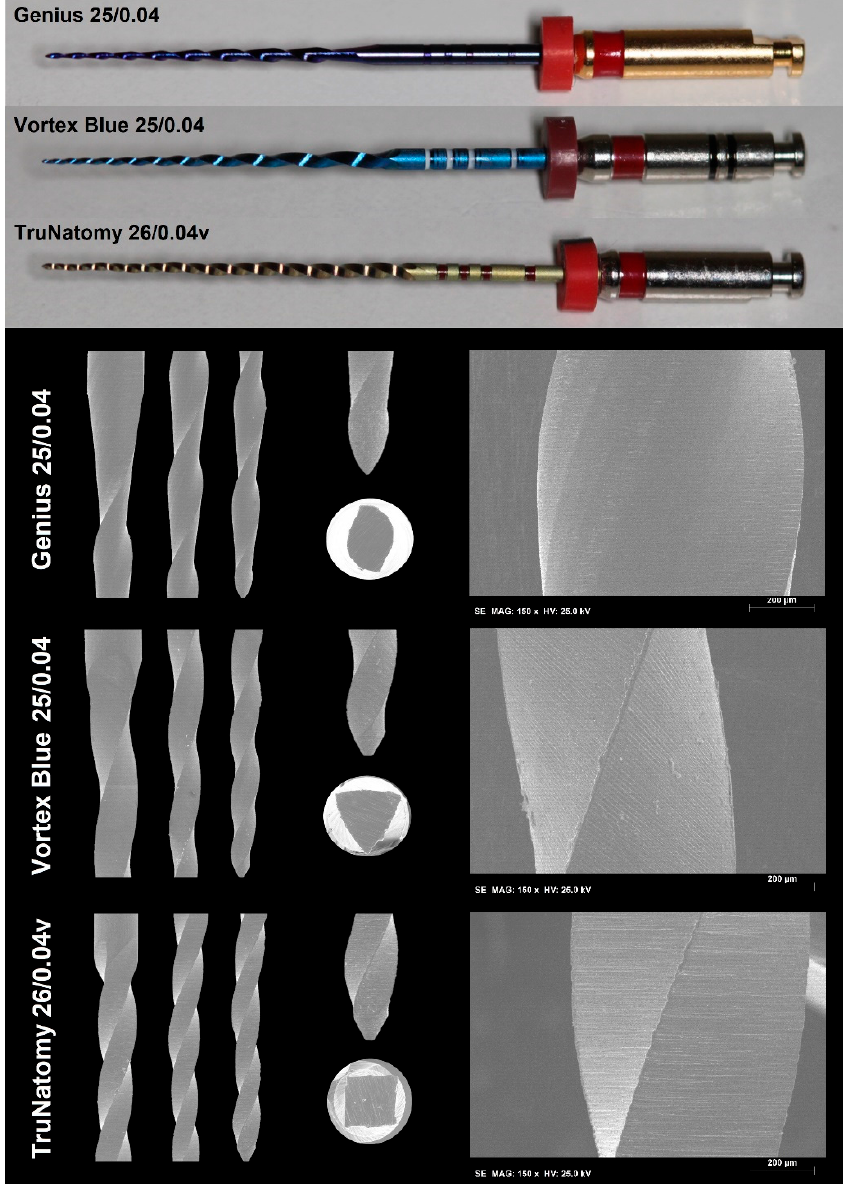
Figure 1. Tested instruments and their design and surface finishing. Macroscopic analyses of the tested instruments (top) showed a higher number of blades in the TruNatomy and distinct colors of the alloy among them. SEM evaluation (bottom) revealed that all instruments have asymmetrical blades, no radial lands and different symmetrical cross sections (square: TruNatomy; triangular: Vortex Blue; S-shaped: Genius Proflex). The tips were non-active, with distinct geometry and transition angles. All surfaces had parallel manufacturing marks, with few irregularities.